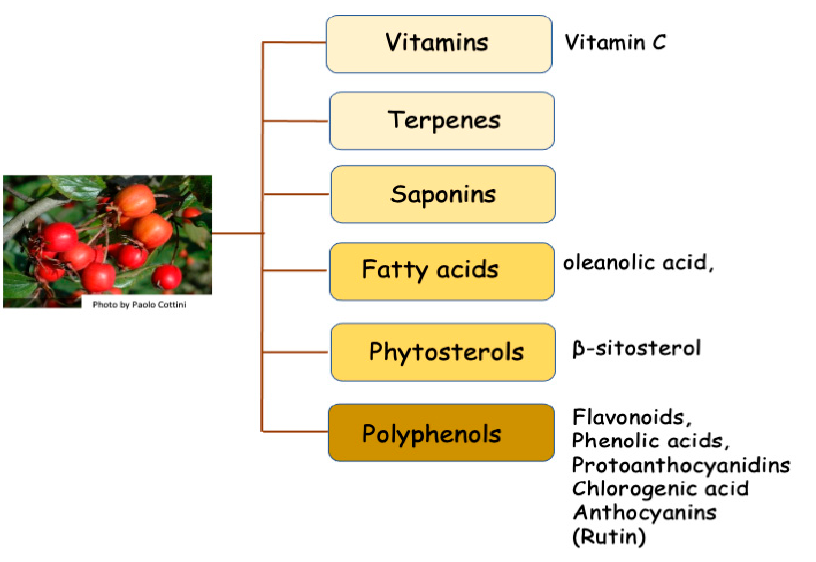
Figure 1. The main phytochemical components of C. monogyna are divided into different principal classes.